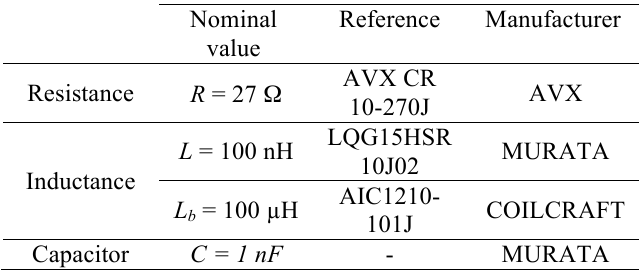
Table 1: References of the passive components constituting the circuit shown in Figure 2.